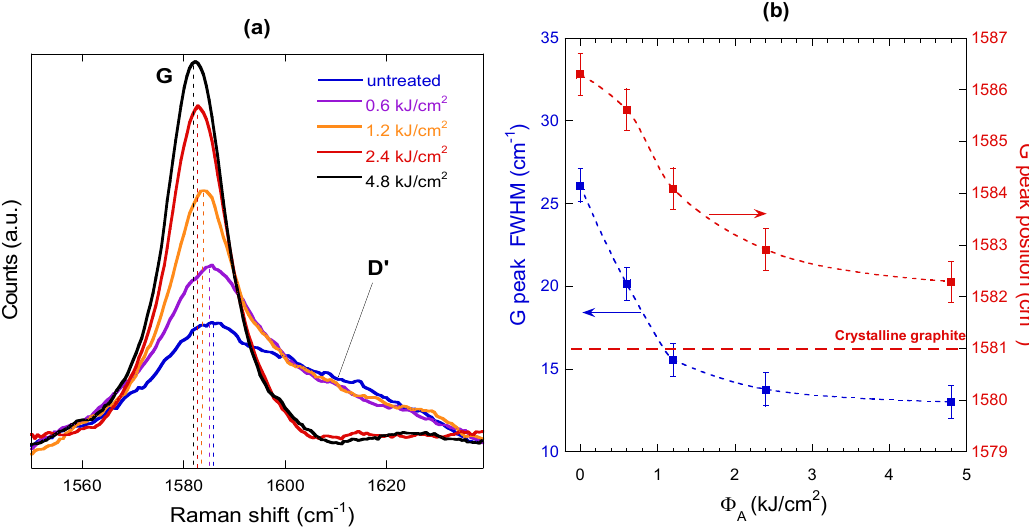
Figure 7. ( a ) G band region of the measured Raman spectra reported in Figure 5, ( b ) G peak full width at half maximum (FWHM) (blue curve) and position (red curve) as a function of the total accumulated laser fluence. Red dashed line at 1581 cm − 1 indicates the G peak position of crystalline graphite when a 514.5 nm laser is used for Raman analysis [32].